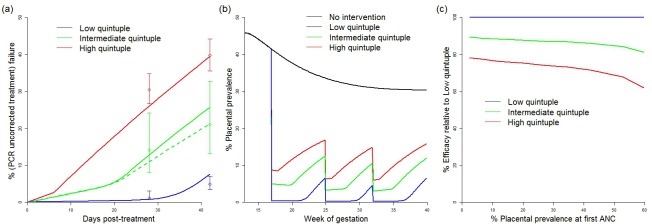
Impact of IPTp-SP upon low birthweight and effect of resistance.(A) Comparison between modelled (lines) and observed (circles with bars indicating 95% confidence intervals) 28- and 42-d failure rates in different resistance settings. Solid lines show a setting where the original prevalence at first ANC visit was 45% (replicating the high transmission settings in which these data were collected) [22]. The dashed green line shows a model simulation from a setting with 20% prevalence at first ANC visit (to reflect the relatively lower prevalence setting of Mansa, Zambia [22]). Prophylaxis in the model is assumed to last for an average duration of 28 d (low quintuple mutation), 14 d (intermediate quintuple mutation), and 7 d (high quintuple mutation). Recrudescent infections (estimated by the PCR-corrected failure rate, not shown) were assumed to reappear uniformly throughout the observation period. (B) Example simulations of placental prevalence by week of gestation in the absence of intervention, and where sulphadoxine-pyrimethamine is given at 17, 25, and 32 wk gestation at the different levels of resistance. (C) How efficacy of IPTp-SP against LBW is assumed to vary by resistance category and transmission intensity (based on changes in the estimated average time spent infected). ANC, antenatal care; IPTp-SP, intermittent preventive treatment of malaria in pregnancy with sulphadoxine-pyrimethamine; LBW, low birthweight.